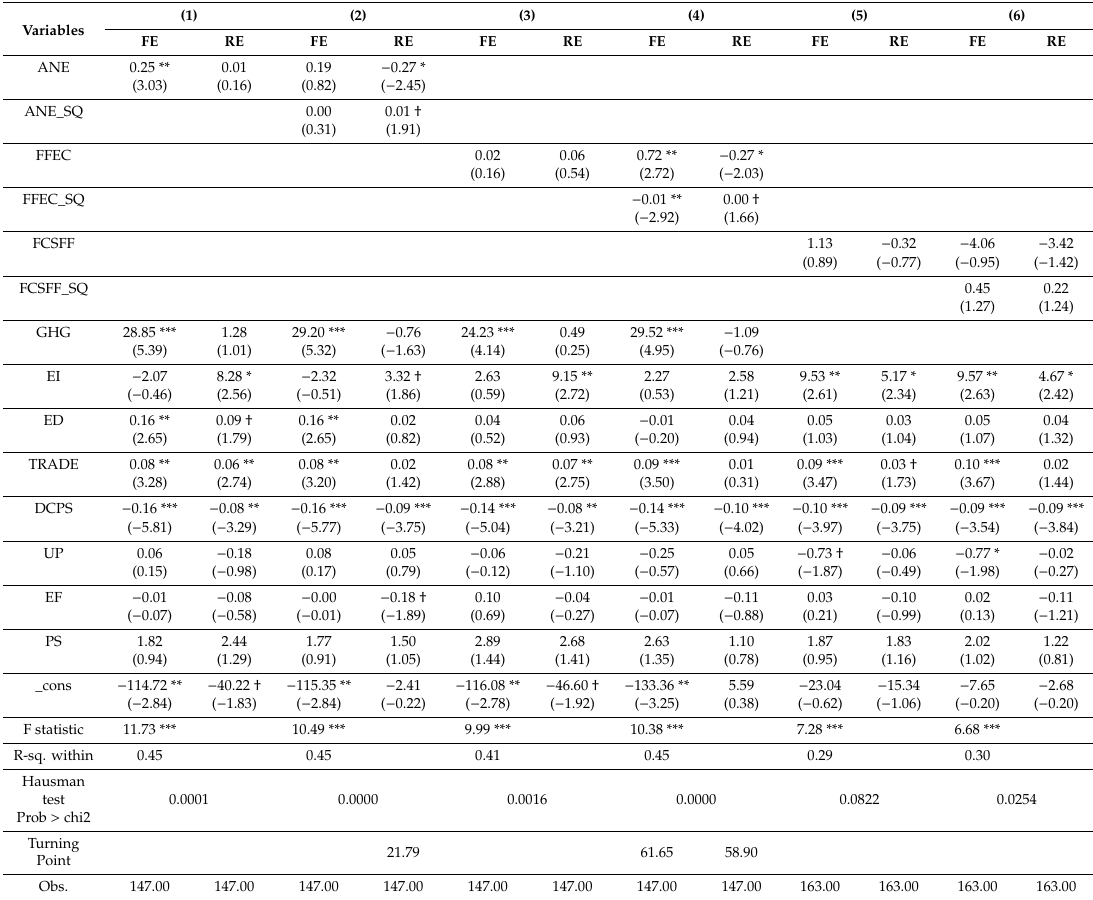
Table 8. Panel data regression models towards the influence of alternative & nuclear energy and fossil fuel energy on economic